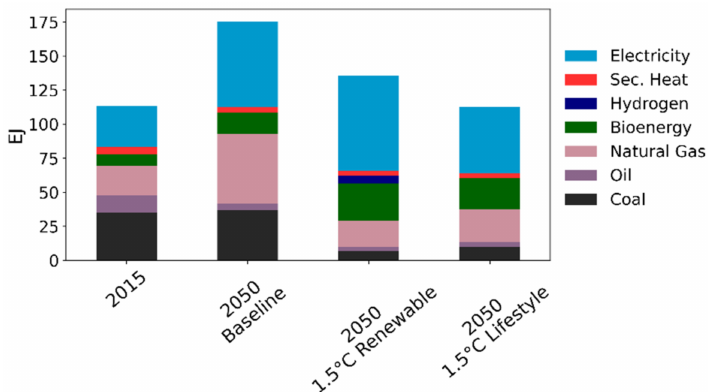
Figure 5. The global energy mix of industry in the baseline and the two 1.5 ◦ C scenarios. (sec. heat = secondary